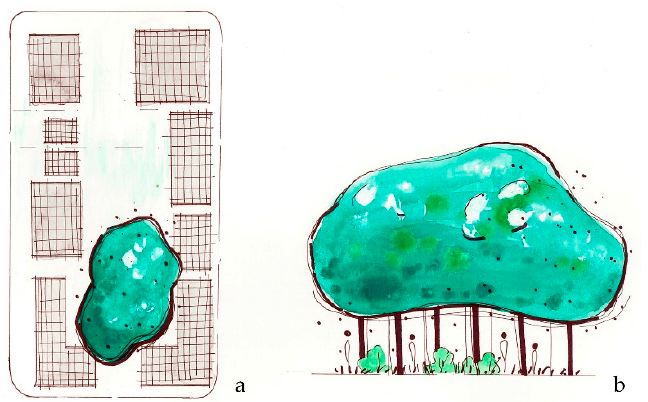
Figure 7. Create refuge suggests that shade from a large area of continuous canopy can provide